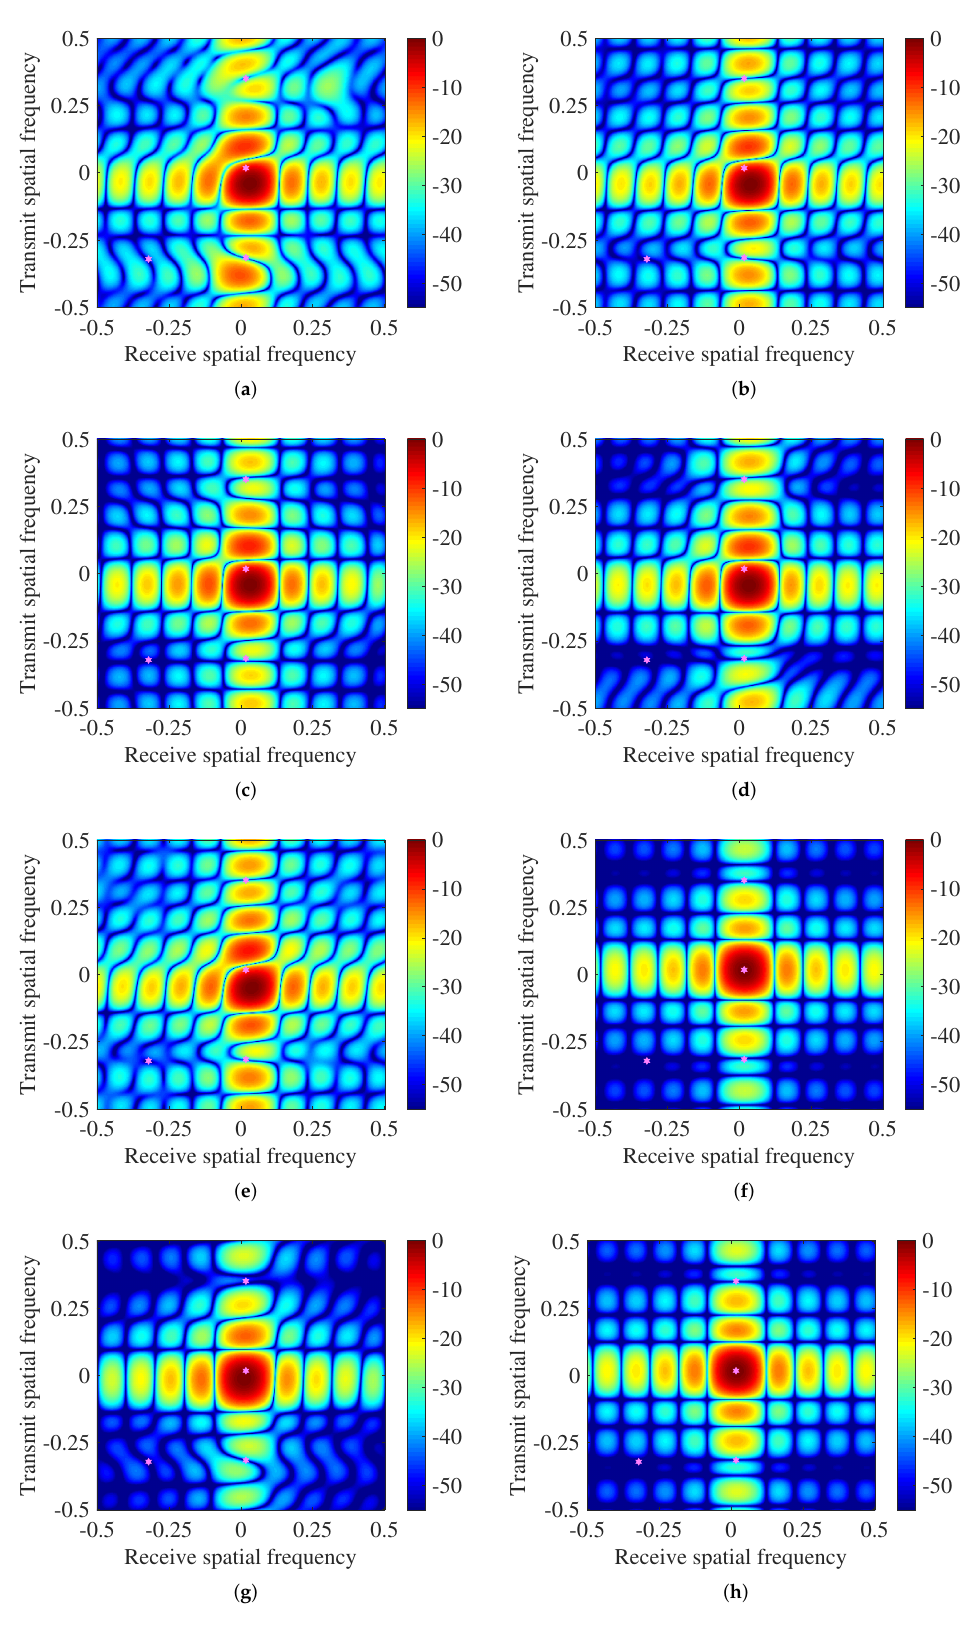
Figure 6. Transmit–receive beamformer of various approaches (SNR = 15 dB): ( a ) Shrinkage. ( b ) Eigenspace. ( c ) IPNCM-linear. ( d ) IPNCM-SPSS. ( e ) Method in [36]. ( f ) IPNCM-SPE. ( g ) IPNCM- MEPS. ( h ) Proposed